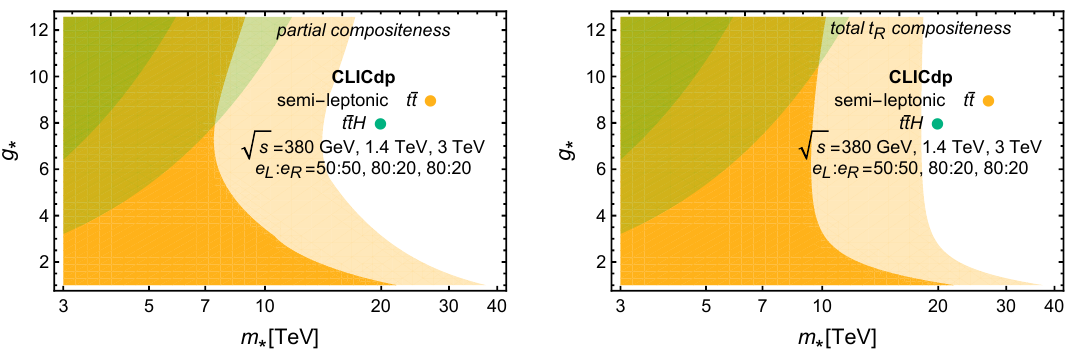
Figure 36. \Optimistic" (light color) and \pessimistic" (dark color) 5 (cid:27) discovery regions for the partial compositeness (left) and the total t compositeness (right) scenarios. The orange contours R are derived from the tt global (cid:12)t in subsection 11.1, while the green contour is derived from the top Yukawa analysis in eq.